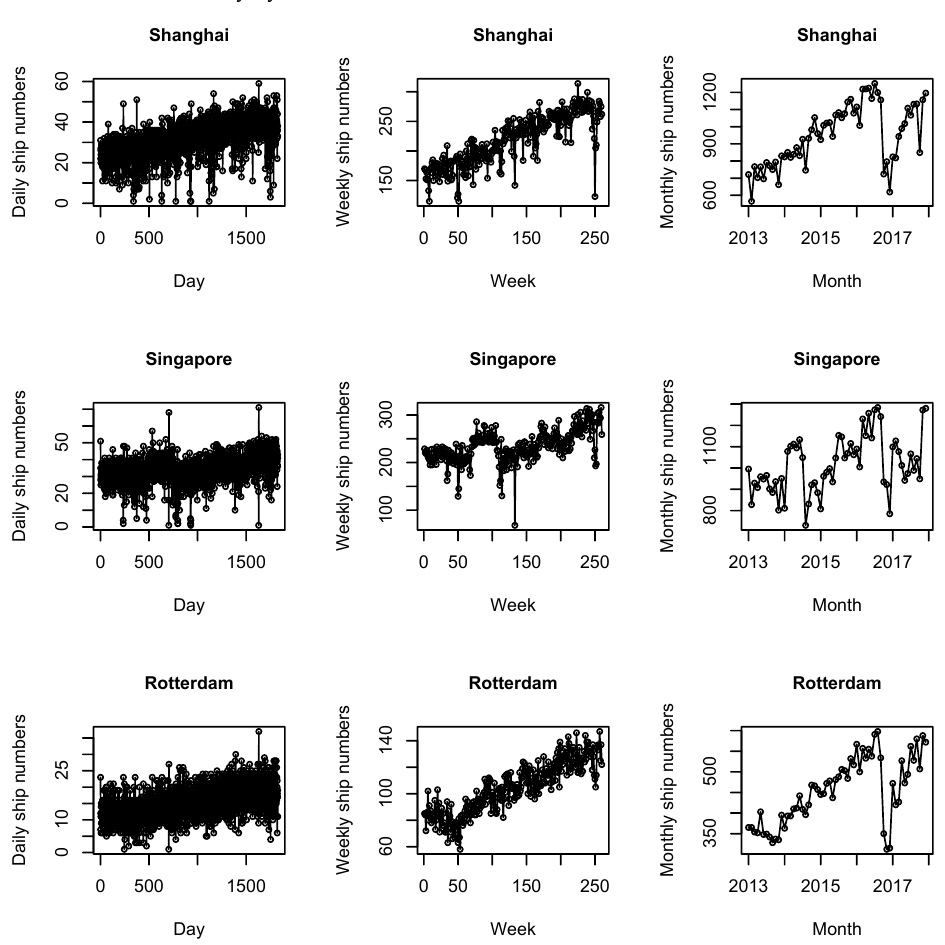
Figure 1. Original data of ship flow of different time scales in three ports.